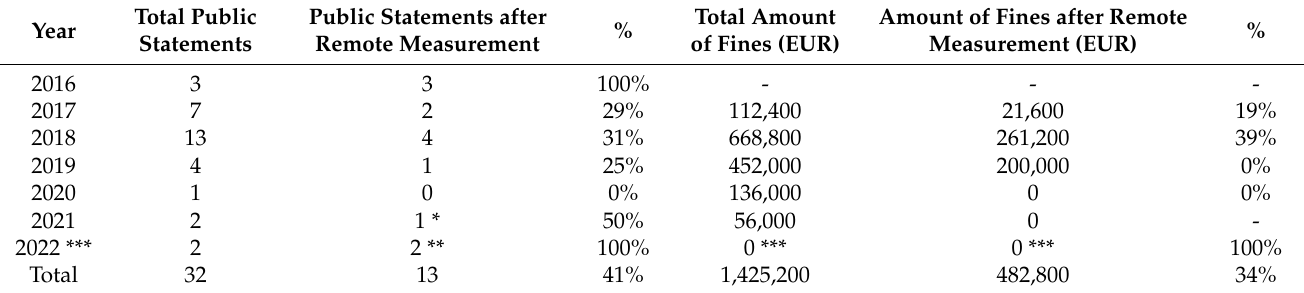
Table 2. Public statements and fines issued by Belgian port inspection authorities in the period